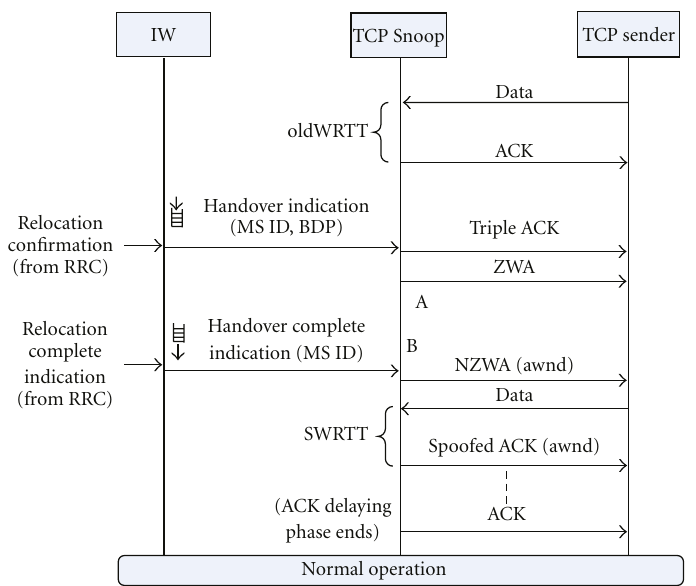
Figure 7: Cross-layer primitives between IW sublayer and TCP